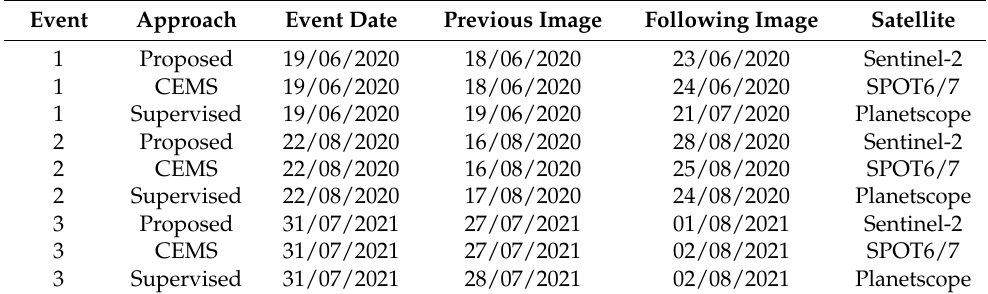
Table 1. List of events examined ( “ 1 ” represents the event in Algarve, Portugal; “ 2 ” represents the event in Eastern Mani, Greece; “ 3 ” represents the event in Aigialeia Municipality, Greece).